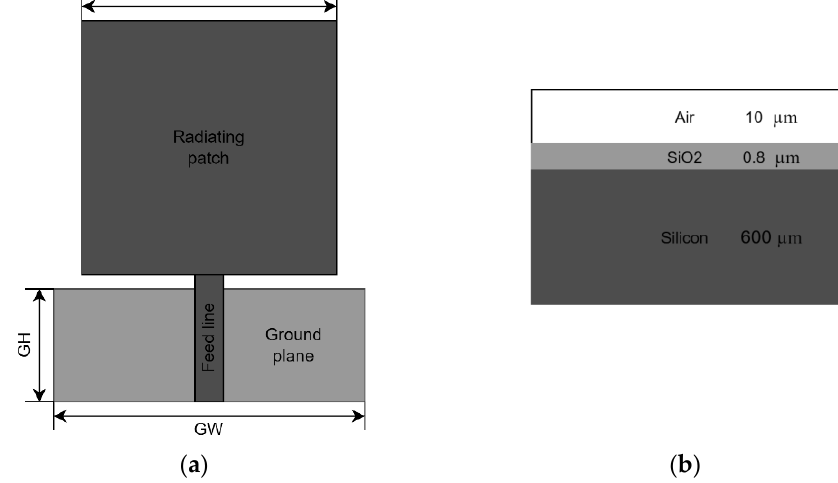
Figure 2. The shape-morphing capability of the pixel antenna is illustrated by representing differ- ent configurations (( a ) bowtie pixel antenna ( b ) Yagi pixel antenna).